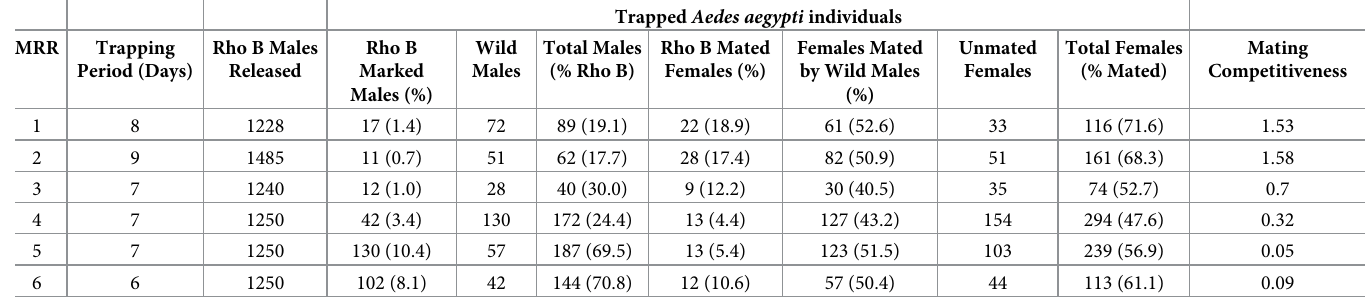
varied during individual experiments (0.7% to 10.4% recaptured), with the mean number of recaptures generally increasing on day two post release (mean = 24.5, SD ± 22.0), before decreasing (Table 1, Fig 2). Recapture success was highly variable between the dry and wet sea- sons, averaging 1.0% (SE ± 0.2) and 7.3% (SE ± 4.3) recaptured, respectively (Table 1). Maxi- mum time to recapture (the period between release and last date of a marked individual captured) varied from three to seven days across all experiments (Table 2). There were signifi- cantly more wild-type male and female Ae . aegypti caught daily in season 2 than in season 1 (Fig 3, F = 18.01, P = < 0.001). (2,41) Estimates of survival and ALE after release varied considerably for each experiment (Table 2). When combining data across all MRR experiments, we estimated the ALE as 1.69 days (PDS = 0.55). The maximum ALE observed in an individual experiment was 4.9 days (PDS = 0.82) during MRR 3, and a minimum of 0.47 days (PDS = 0.12) during MRR1